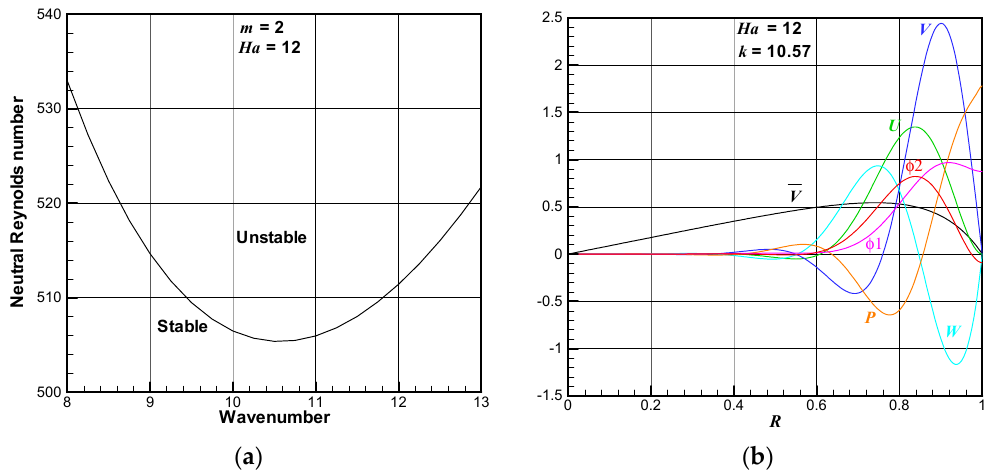
Figure 7. The neutral stability curve at m = 2 and Ha = 12 shown in ( a ) and the amplitude functions for m = 2, k c = 10.57 and Ha = 12 shown in ( b ).